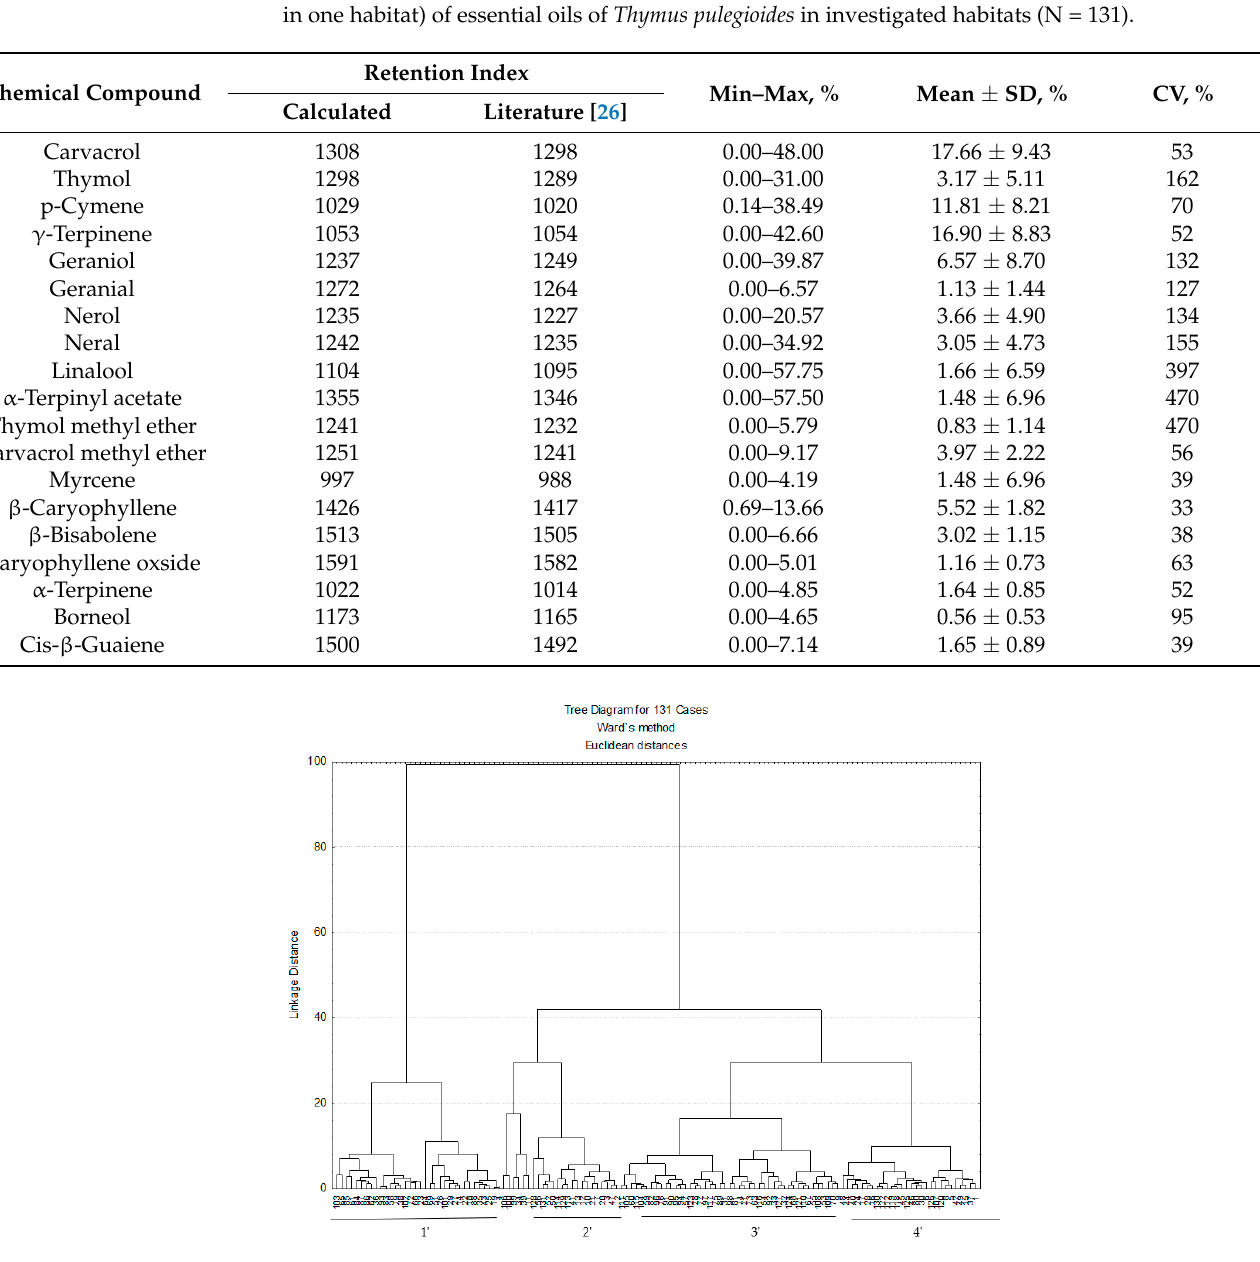
Figure 3. Comparison of amount of essential oil in Thymus pulegioides habitats in different Lithuania climatic sub-districts. Explication: A—Aukštaitija climatic sub-district, D—Dz ū kija, M-N—M ū ša Nev ė žis, NL—the Nemunas Lowland, S—S ū duva, V—Venta, Z—Žemai č iai, P—Paj ū ris, PL—Pa- j ū ris Lowland. The statistical significances between climatic sub-districts has not been established.